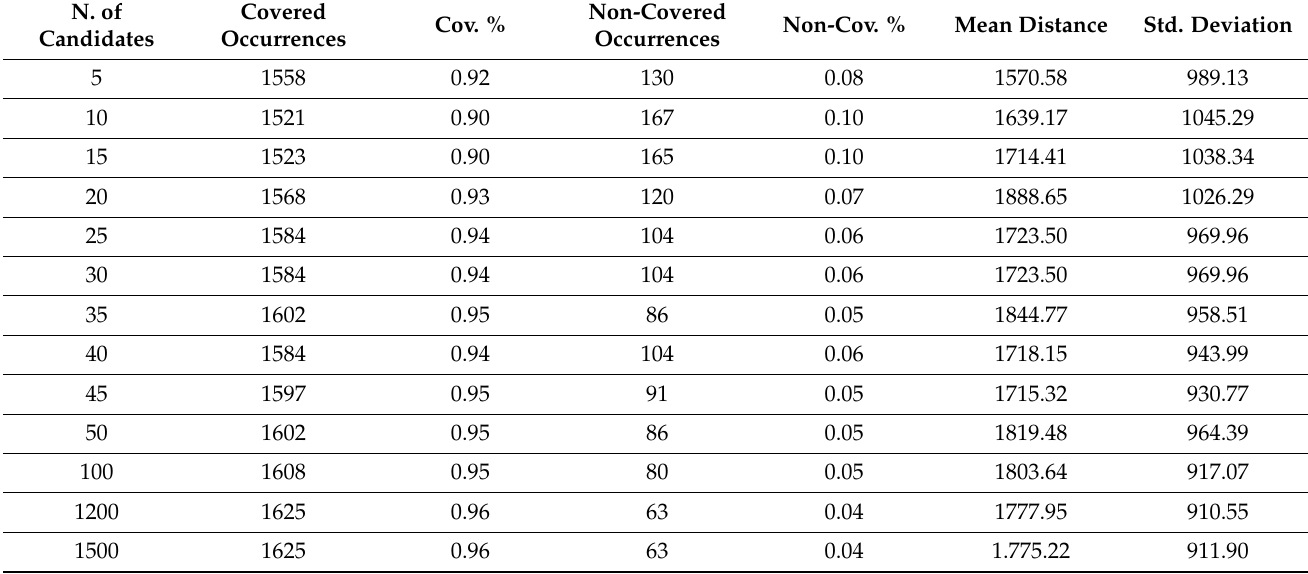
Table 3. Sensitivity analysis of the number of candidates.